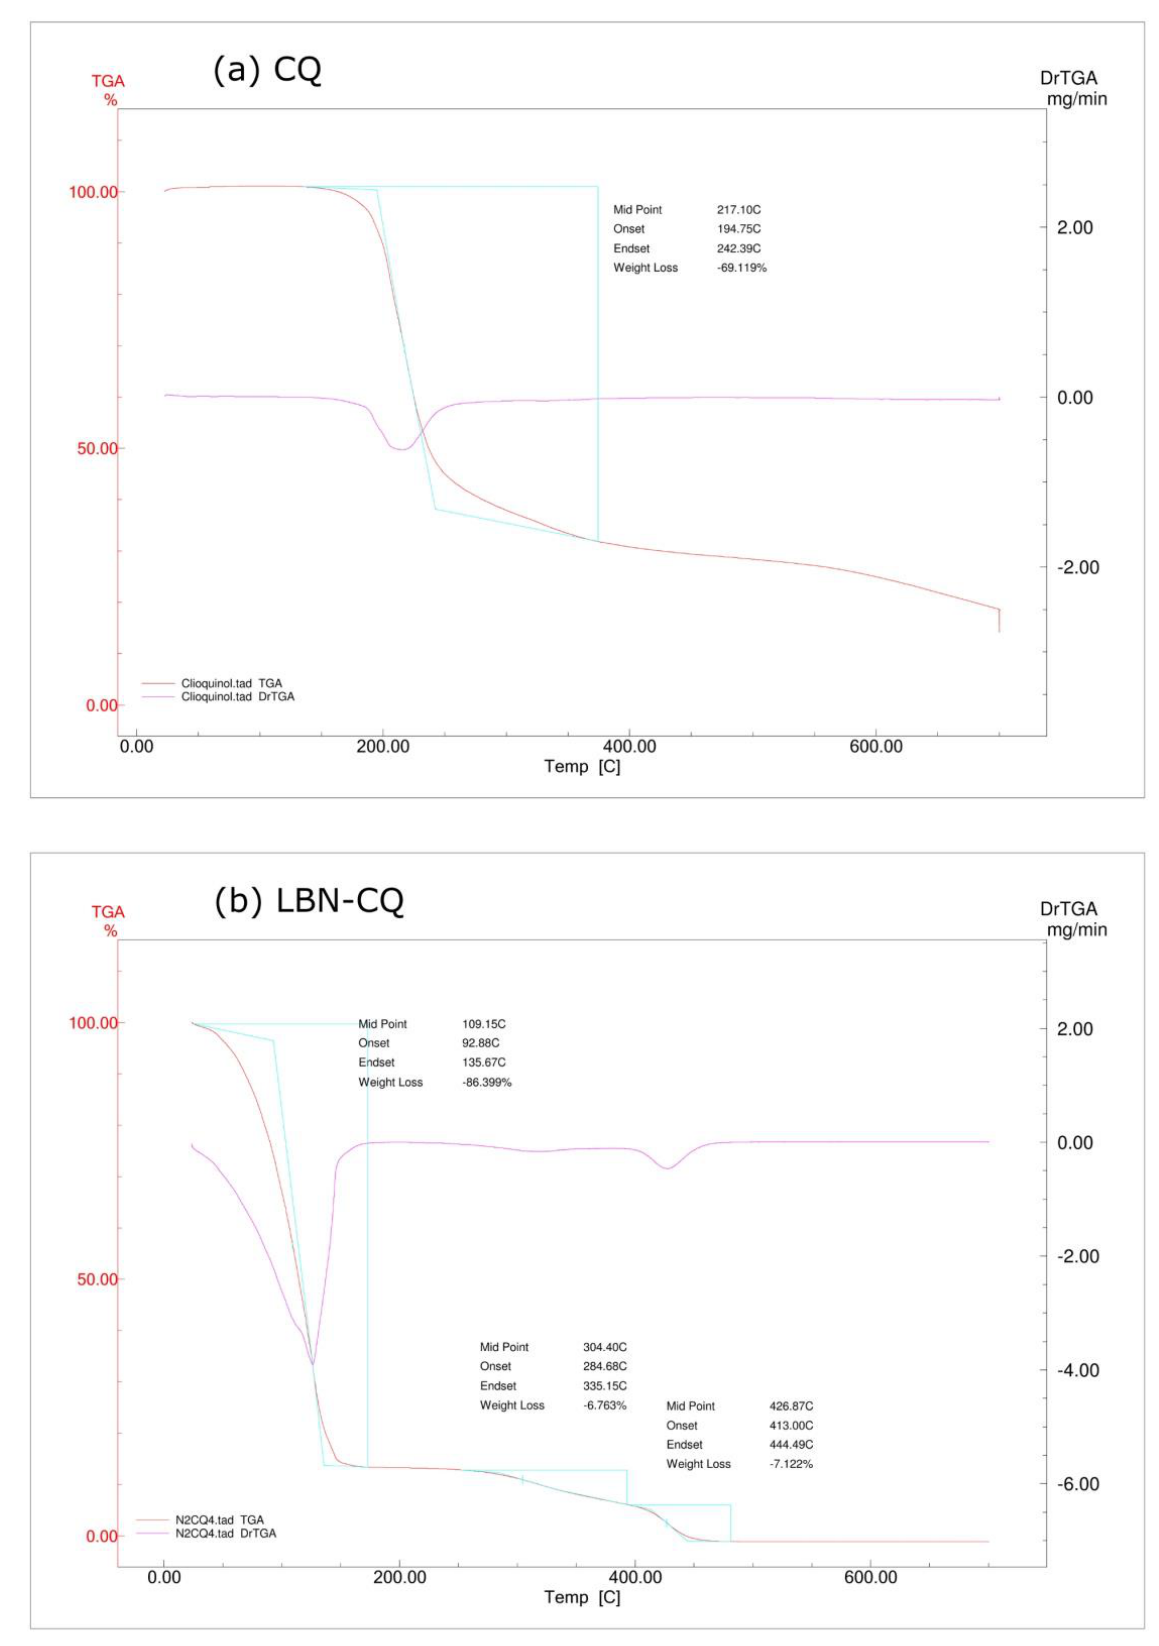
Figure 4. Thermogravimetric analysis thermogram of CQ ( a ) and LBN-CQ ( b ).